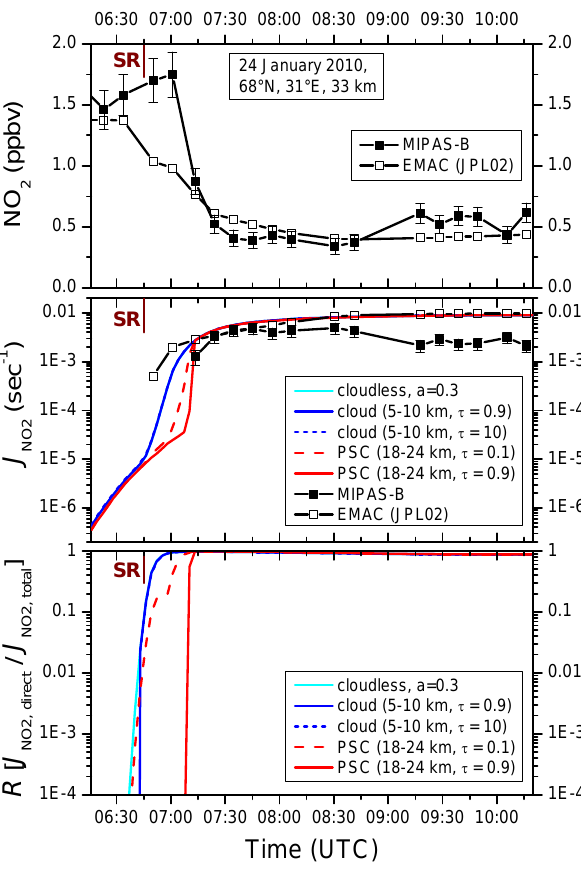
Fig. 12. Top panel: Measured and modelled temporal behaviour of NO 2 at 33km. A temporal delay in the observed NO 2 decrease after sunrise is clearly visible. Middle panel: NO 2 photolysis frequencies ( J NO ) as calculated with the TUV (version 5.0) radiation model 2 (bluish curves lie close together) along with photolysis frequencies from EMAC and MIPAS-B (estimated assuming steady state, see text) are shown for comparison. While tropospheric clouds have no significant influence on the photolysis rate, PSC strongly affect J NO . Bottom panel: Ratio R of the direct to total fraction of the 2 NO 2 photolysis frequency as calculated by TUV. Around sunrise, the diffuse radiation dominates the NO 2 photolysis rate. Annotation as per Fig. 6.